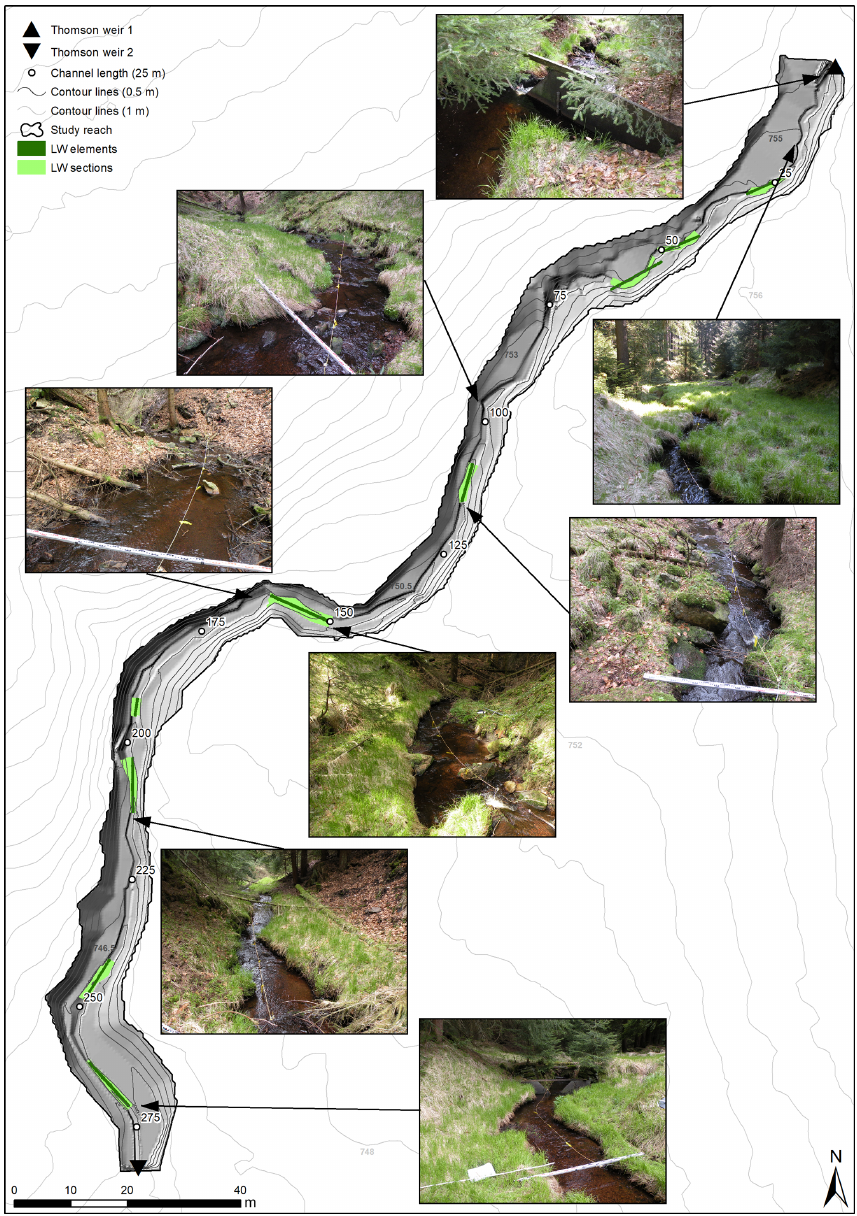
Figure 2. Detailed map of the study reach (topographic data outside reach: GeoSN, 2008). Photographs were taken 9 years after the field experiments in May 2017 in the direction of flow (north to